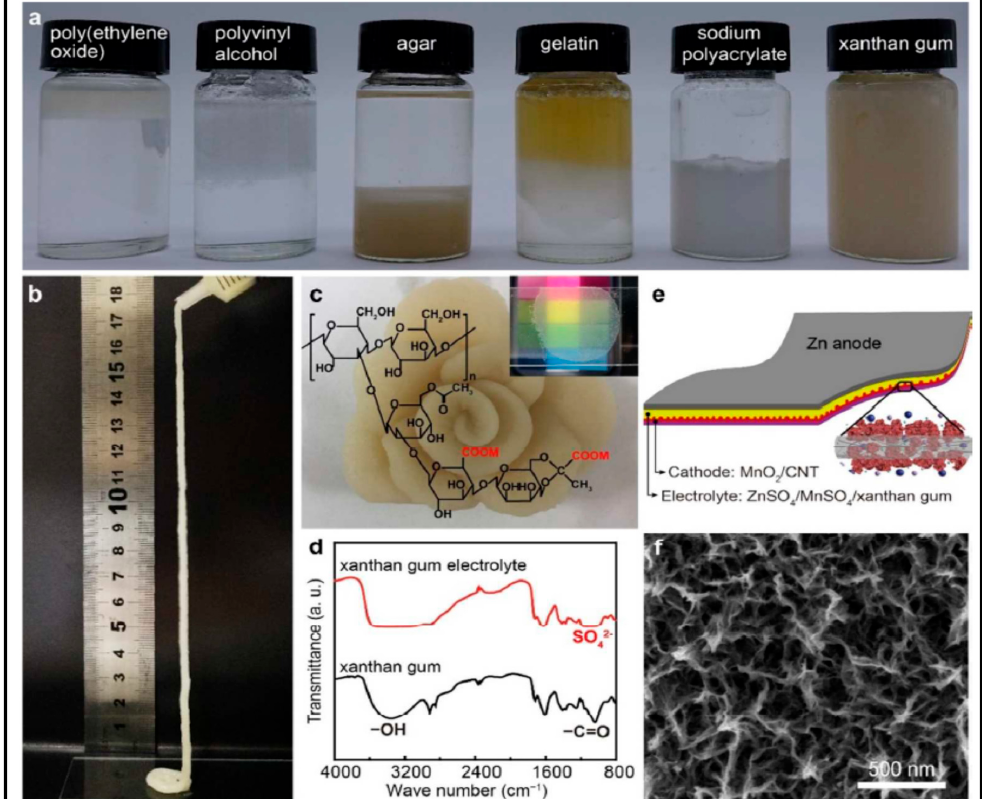
Figure 21. ( a ) Photograph of aqueous solutions of 2 M ZnSO 4 and 0.1 MnSO 4 after adding 10 wt.% polymers of poly(ethylene oxide) (PEO), polyvinyl alcohol (PVA), agar, gelatine, sodium polyacrylate and xanthan gum showing that PEO, PVA, agar, gelatine and sodium polyacrylate were aggregated while xanthan gum was uniformly dissolved in the solution. ( b ) Photograph showing that the sticky xanthan gum electrolyte could extruded from a syringe and self-support at a long length. ( c ) A hand-made flower using the xanthan gum electrolyte, the molecular formula of xanthan gum floating on the flower, and the top-right photo showing that the xanthan gum electrolyte can be readily shaped into a 10-µm-thick film. ( d ) IR spectra of xanthan gum and the xanthan gum electrolyte. ( e ) Schematic showing the structure of our gum Zn–MnO 2 battery, which consists of a zinc foil as the anode, a ZnSO 4 /MnSO 4 /xanthan gum film as the separator and the electrolyte, and a MnO 2 /CNT film as the cathode, respectively. The pop-up shows the structure of the MnO 2 /CNT electrode, where a porous MnO 2 layer is coated on a CNT thin-film. ( f ) SEM image of the MnO 2 /CNT hybrid film. Reproduced with permission from [64]. Copyright 2018 Royal Society of Chemistry.